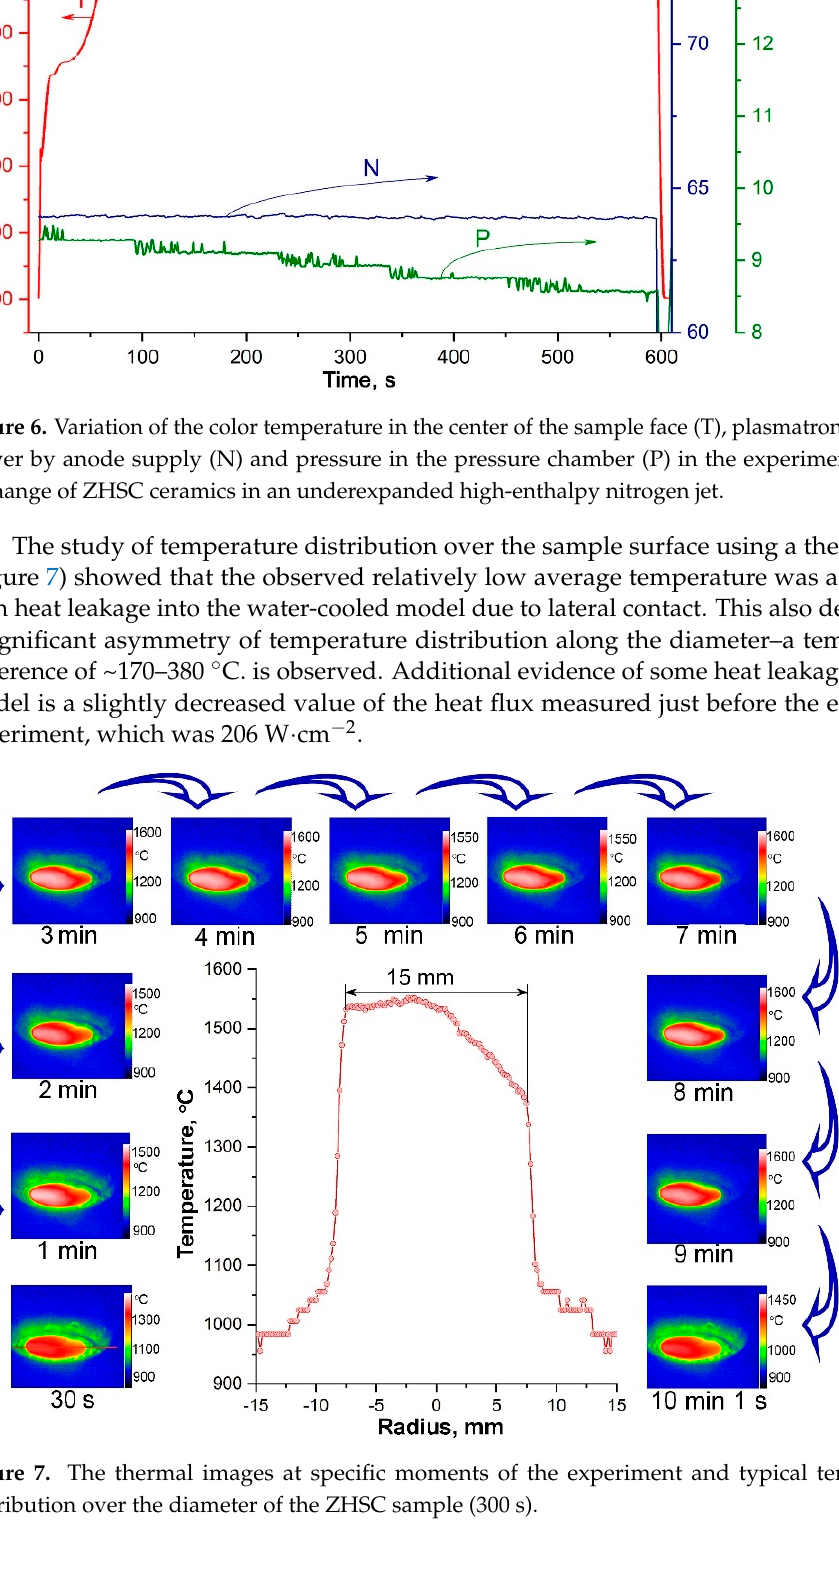
Figure 7. The thermal images at specific moments of the experiment and typical temperature distri- bution over the diameter of the ZHSC sample (300 s).